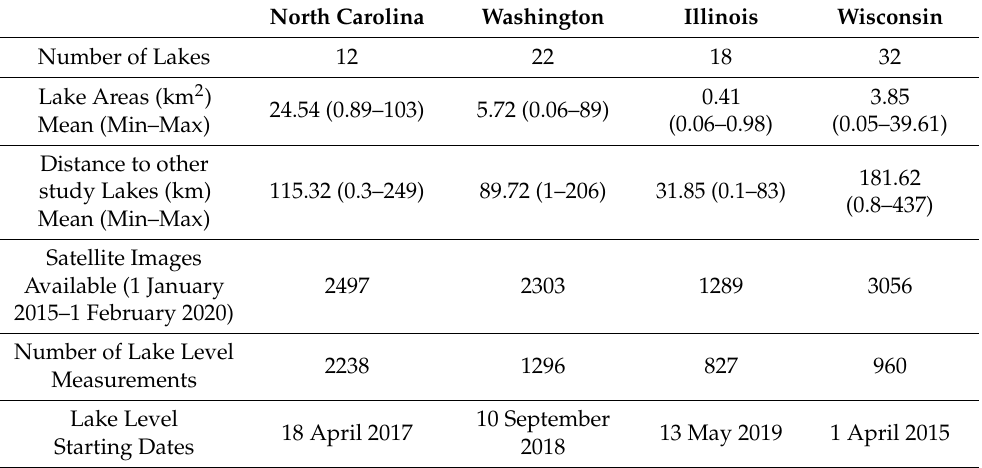
Table 1. Comparison of lake level monitoring attributes between